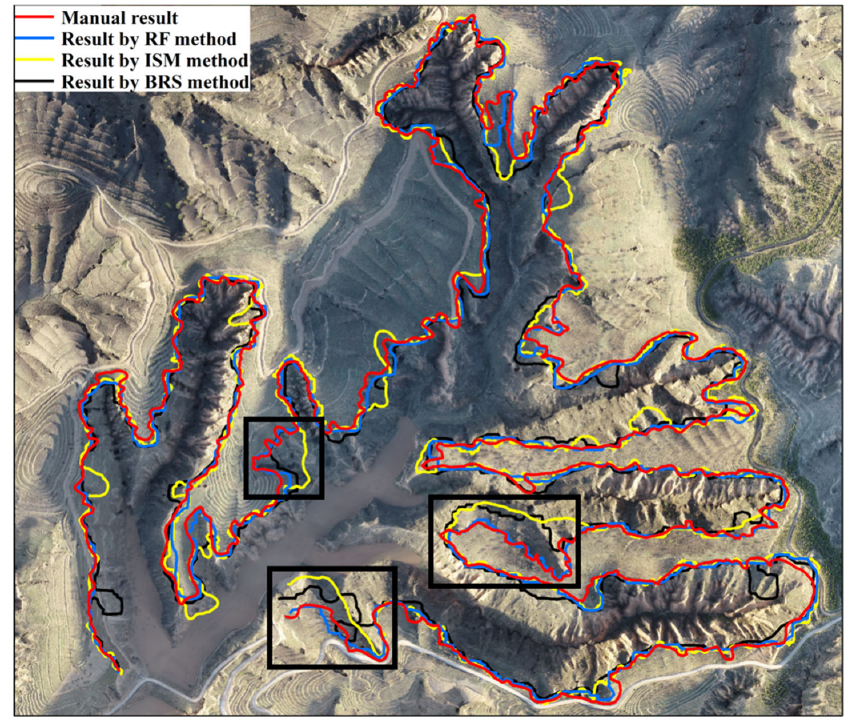
Figure 14. Comparisons of the proposed method with the three extraction methods.